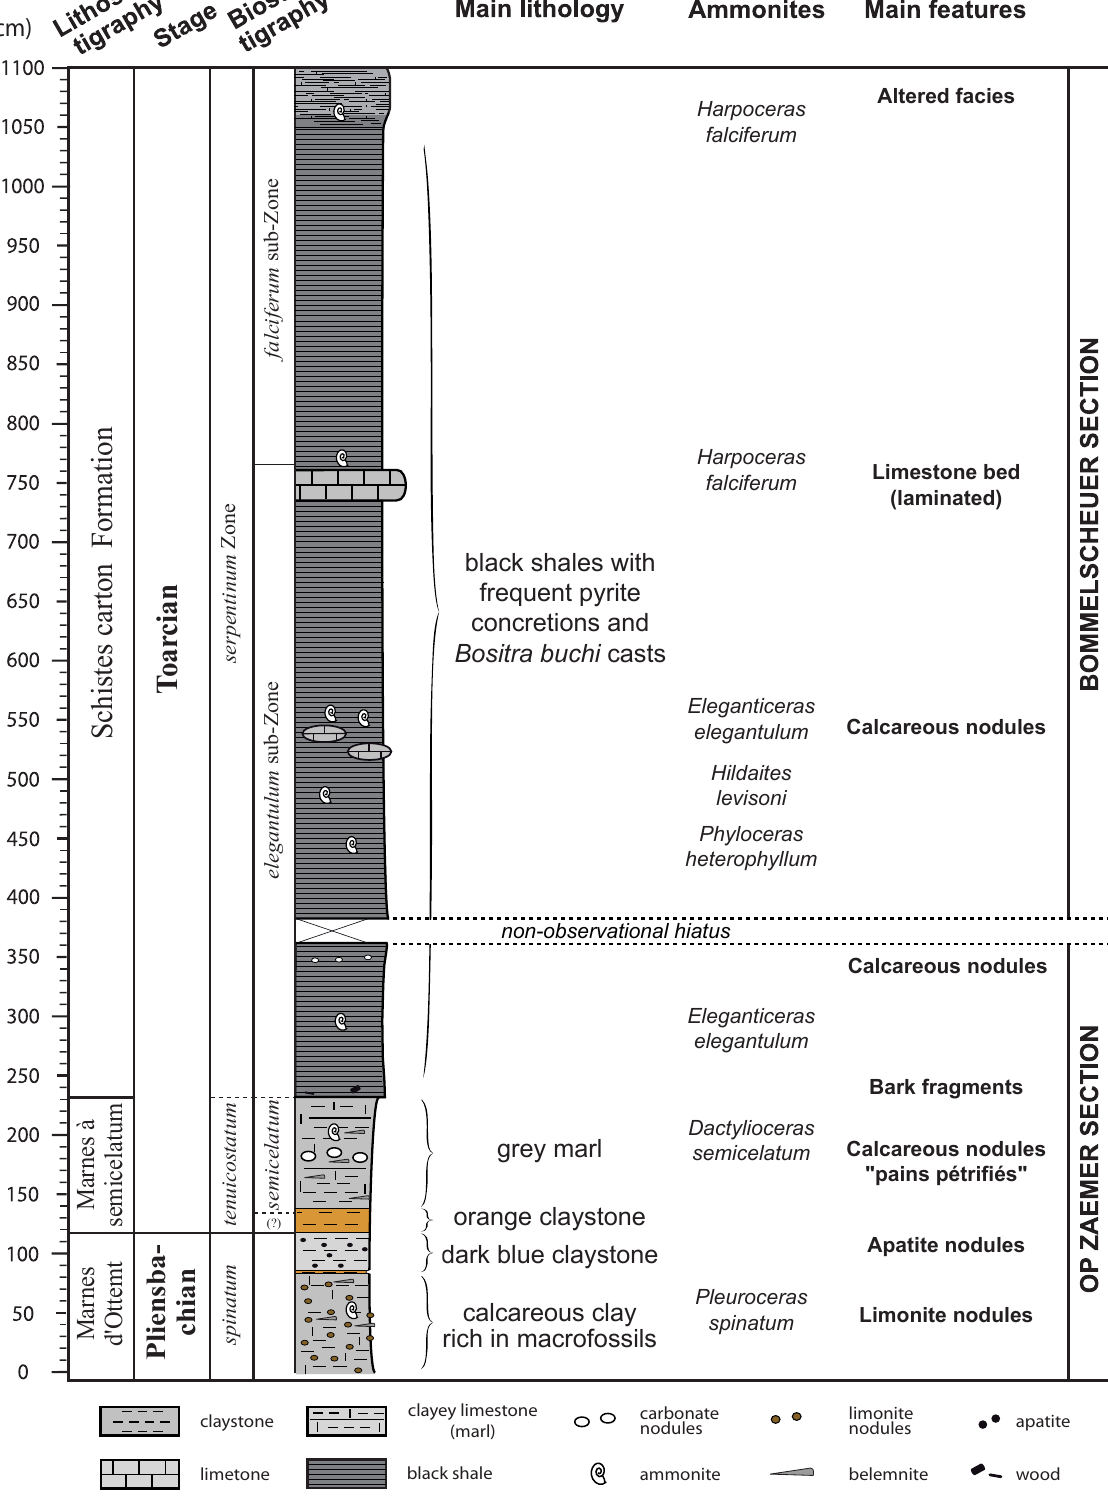
Solid Earth, 5, 793–804,